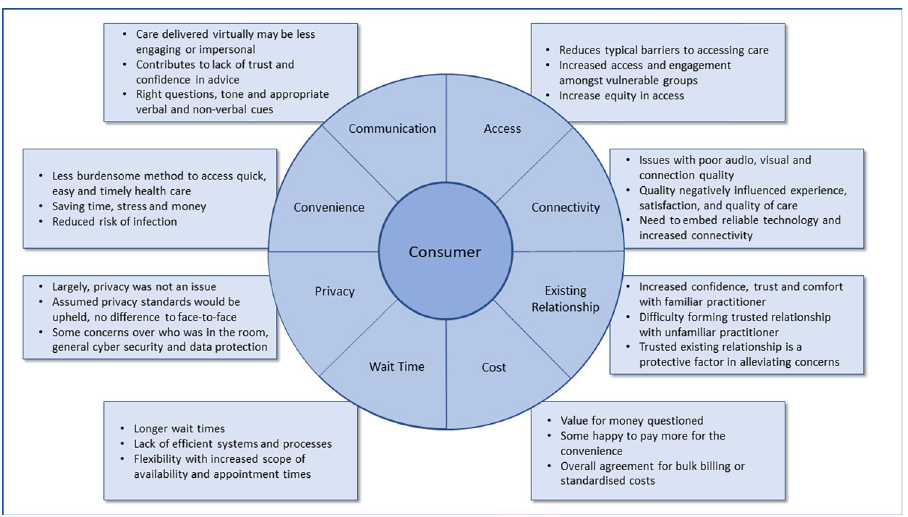
Fig 1. Illustration of the eight core themes relating to the benefits, barriers, enablers, and future improvements of